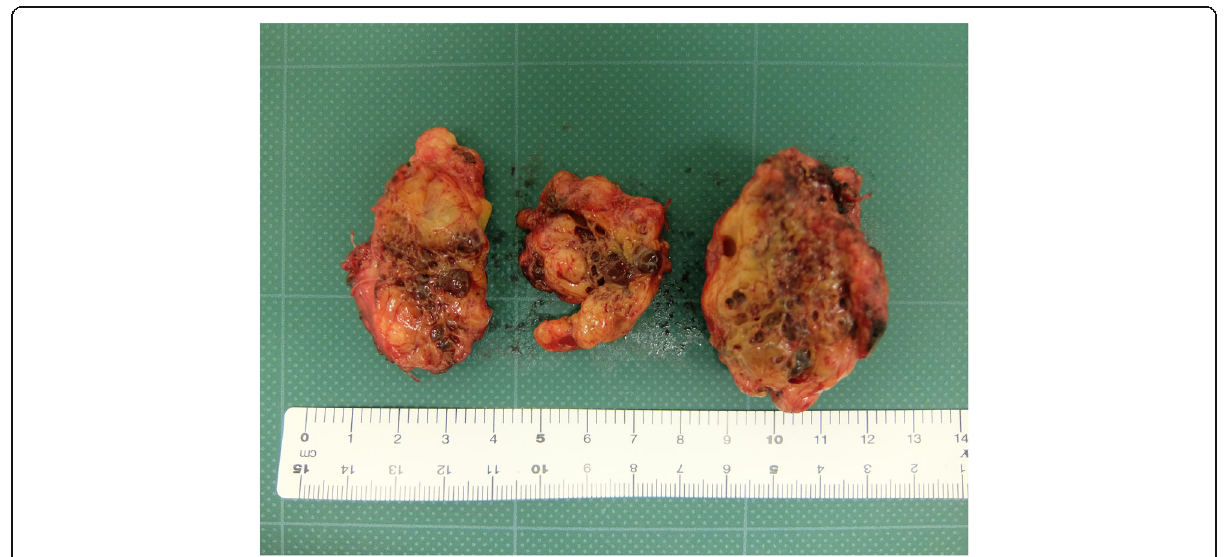
Fig. 4 Macroscopically, the tumor showed spongioid appearance of the cut